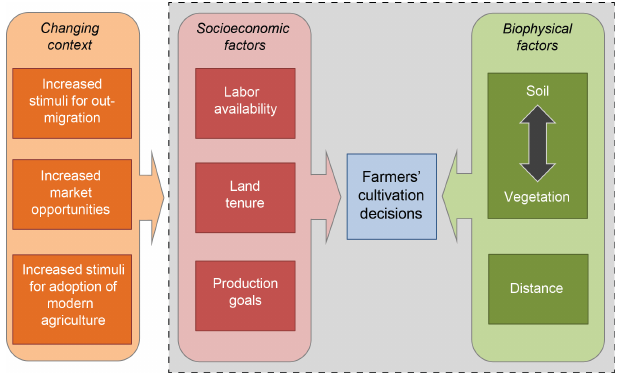
Fig. 3 . Schematic representation of the most important socioeconomic (red) and biophysical (green) factors that farmers take into account in their decision making during shifting cultivation and of the major changes (orange) that they recognize in their socioeconomic